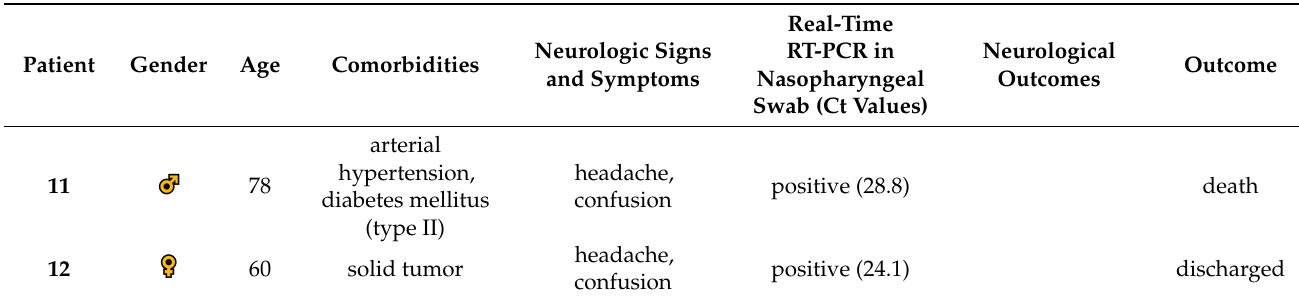
Table 2. Cont. . Table 2. Demographic and clinical features of neuro-COVID group.